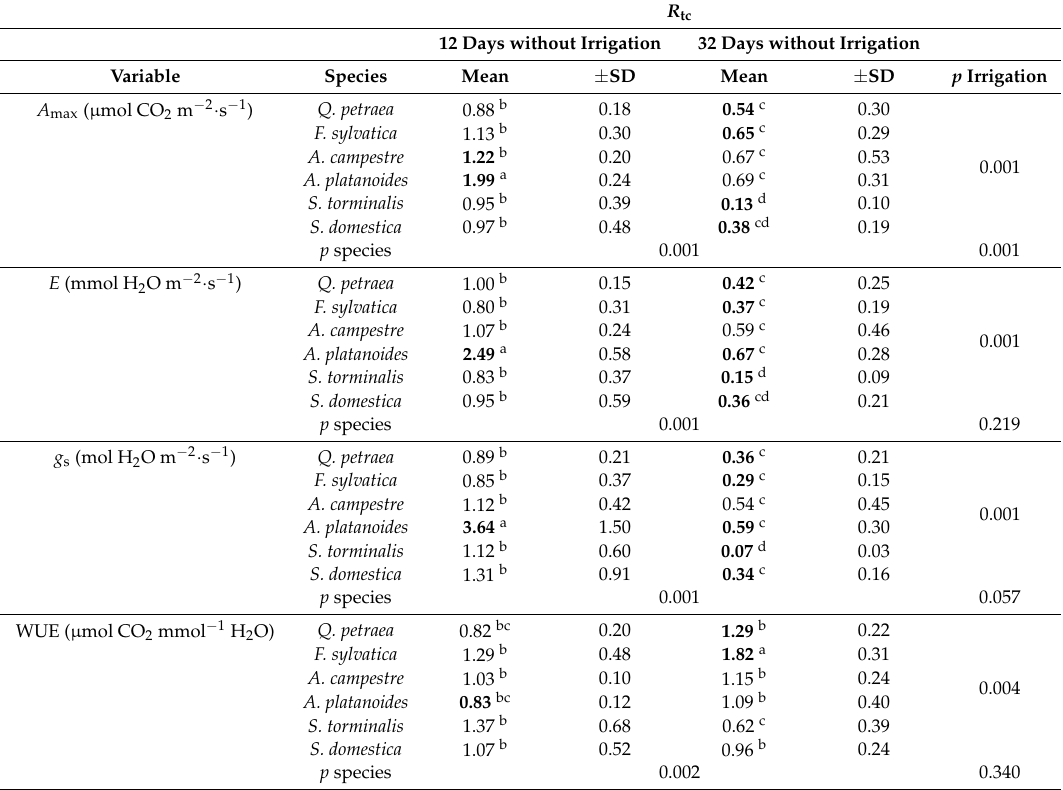
Table 4. Means and standard deviation ( ± SD) of the resistance in relation to control ( R tc ) for maximum photosynthetic rate ( A max ), transpiration rate ( E ), stomatal conductance to water vapor ( g s ), and water use efficiency (WUE) for control and dry treatments after 12 and 32 days without watering, respectively. Values in bold type indicate a statistically significant deviation of the indices from unity (95% of the confidence intervals do not overlap with 1). Species and treatments sharing the same lower case letters were significantly different ( p < 0.05); n = 24 per tree